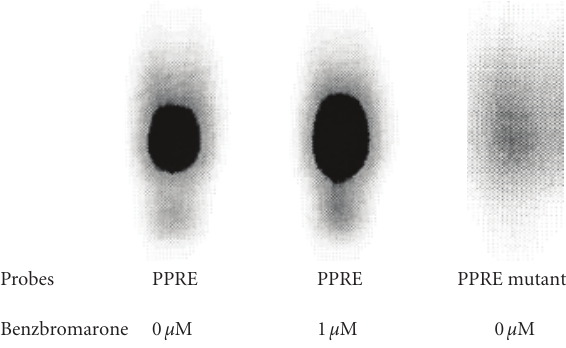
Figure 3: Comparative analysis of PPARs DNA-labeled PPRE com- plex by EMSA in nuclear extracts of 293T cells with or without benzbromarone treatment for 24 hours. Presence of PPRE was ver- ified by incubation with mutant PPRE